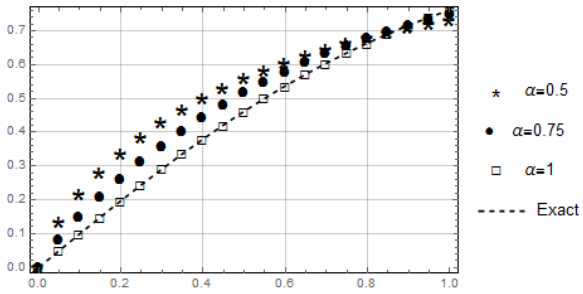
Fig. 1: Comparison betwixt the exact and the approximation solution with F -transform of test example 5.1 for n = 500 , τ = 0.002 and various values of t and α with Caputo-Fabrizio